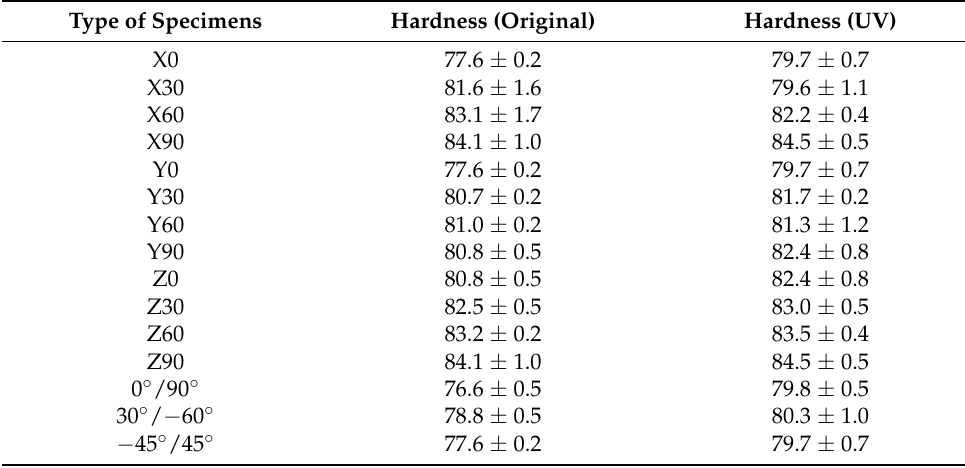
Table 5. The hardness (Shore D) measurement results on the edge